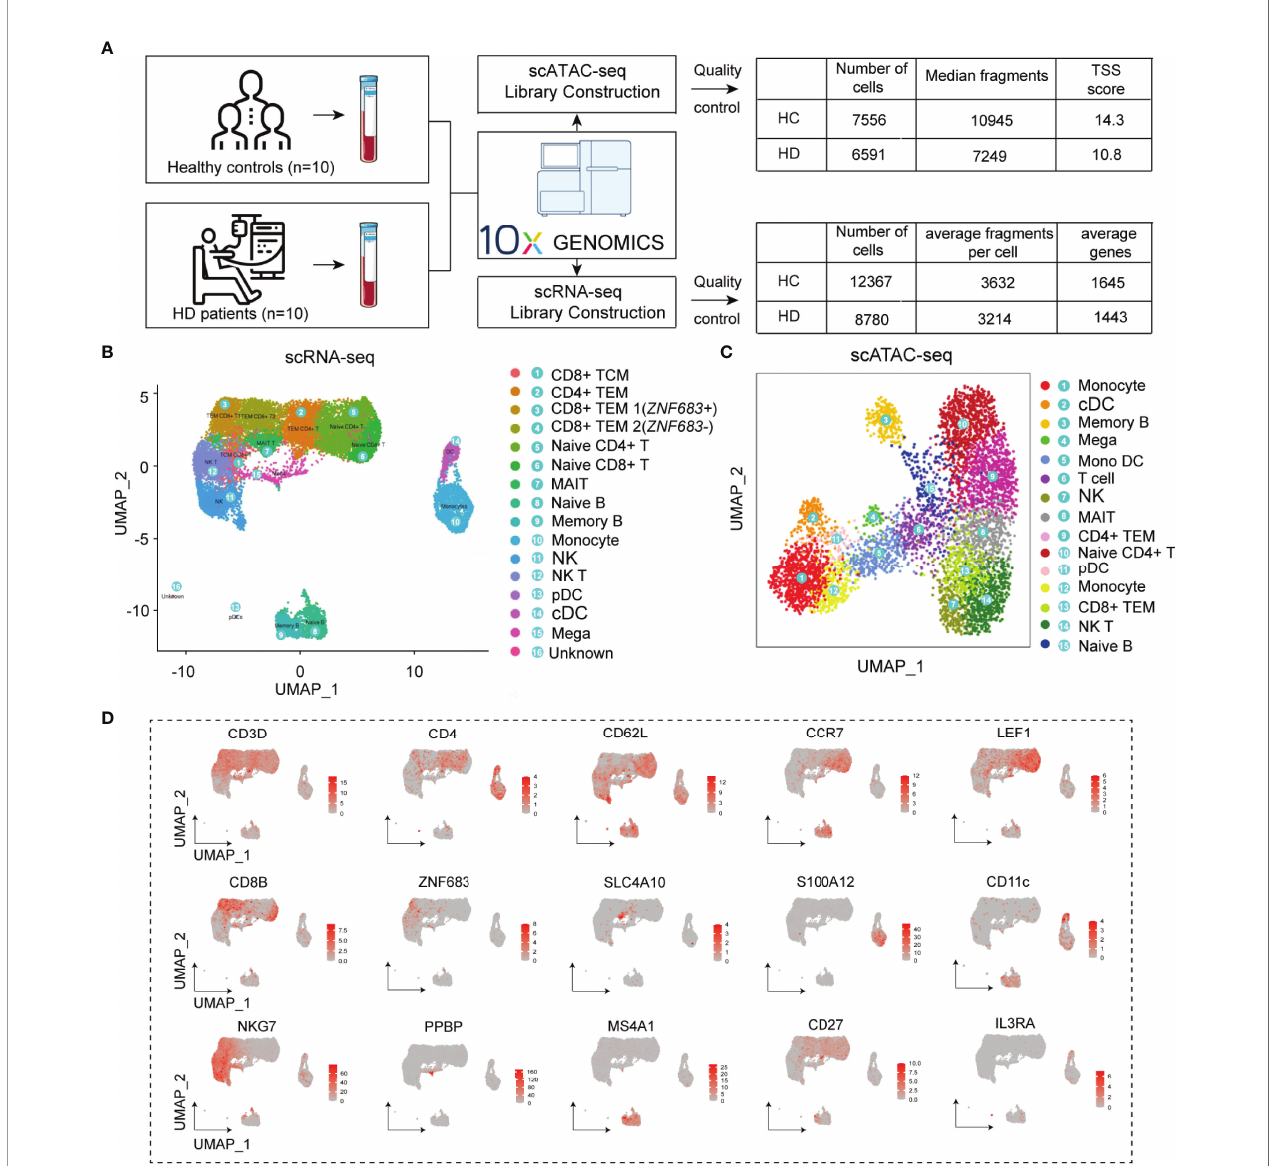
FIGURE 2 | Cell type identi fi cation of scRNA-seq and scATAC-seq clusters. (A) Flowchart of the study and results of data quality control. (B) UMAP plots visualizing clusters of PBMCs derived from scRNA-seq data. (C) UMAP plot visualizing clusters of PBMCs derived from scATAC-seq data. (D) UMAP plots showing representative marker gene expression levels in the PBMC subpopulations. PBMC, Peripheral blood mononuclear cell; UMAP, uniform manifold approximation and projection for dimension